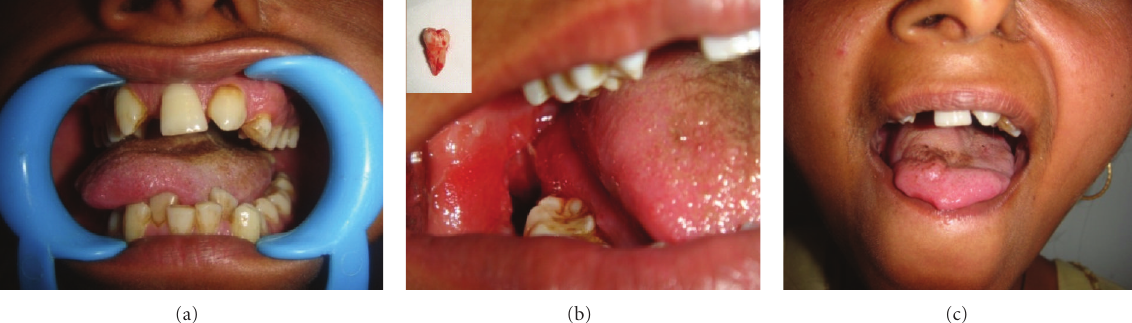
Figure 4: (a) Inability to protrude the tongue and on e ff ort protrusion, the tongue deviated to the right. (b) Impacted third molar extracted. (c) Improvement within two weeks of